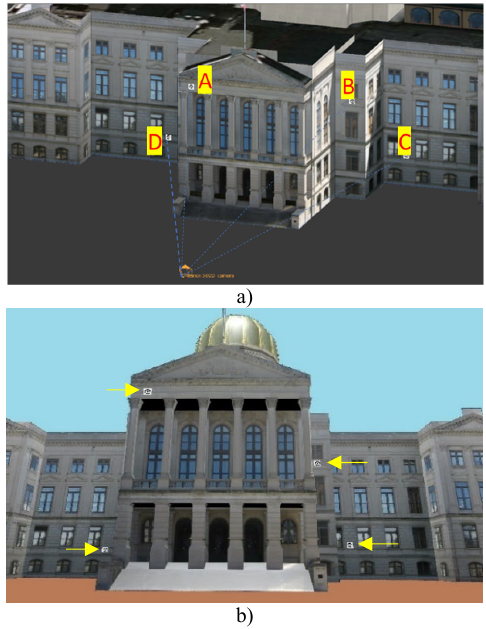
Figure 11. Convergence of pose corrections to zero values of the simulated test of a perspective image.